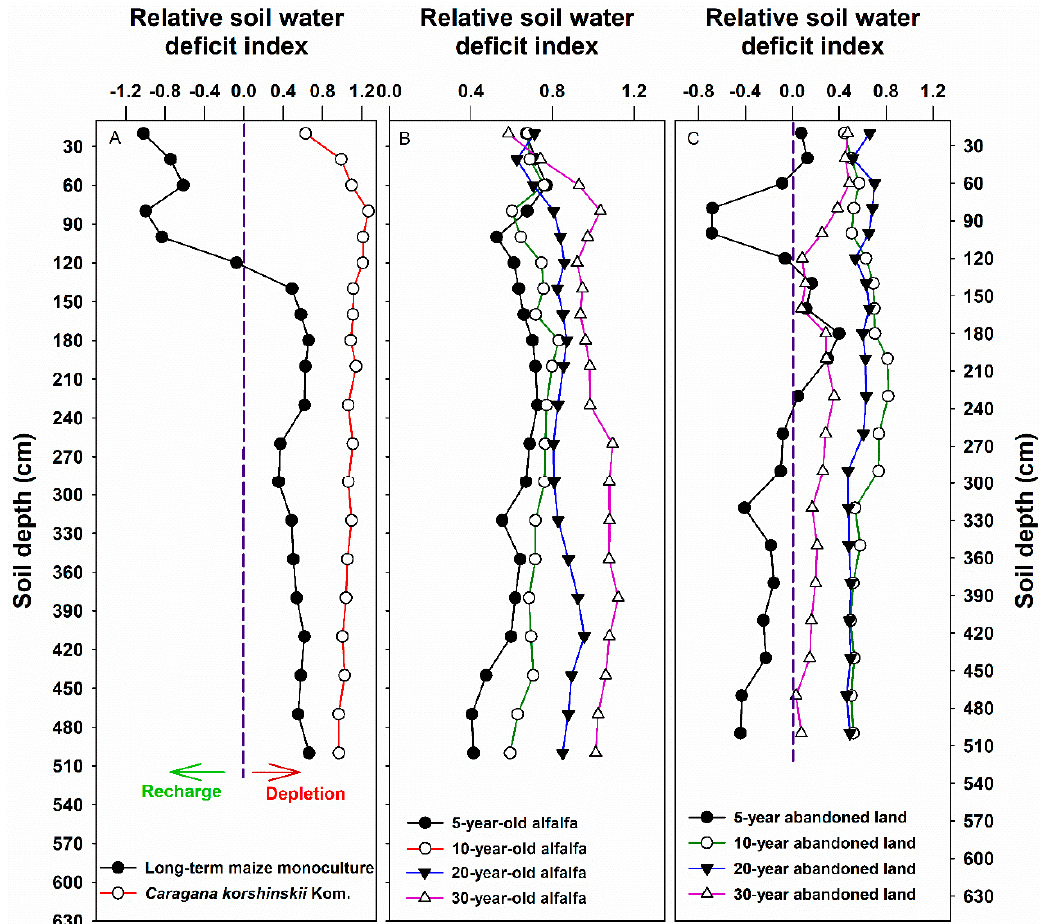
Figure 4. Effects of land use on the relative soil water deficit index in the 0–500 cm soil profiles under long-term maize and Caragana korshinskii Kom (A), alfalfa (B) and abandoned land (C).